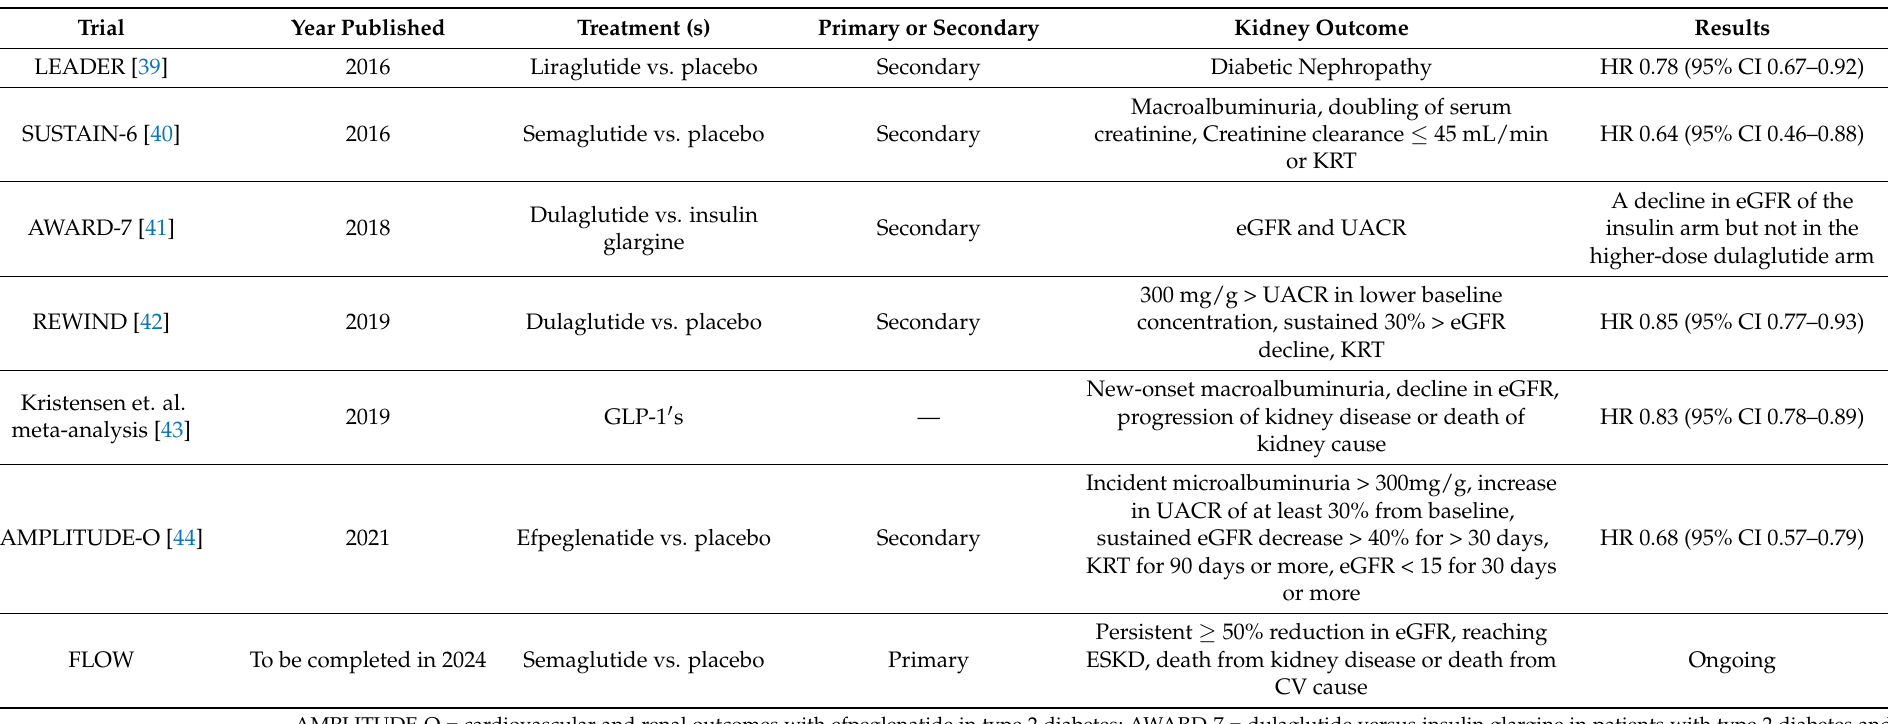
Table 3. Summaries of landmark trials with GLP-1